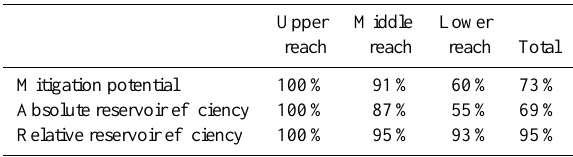
Table 6. Reservoir efficiencies and mitigation potential for the reservoirs operation rules in the present